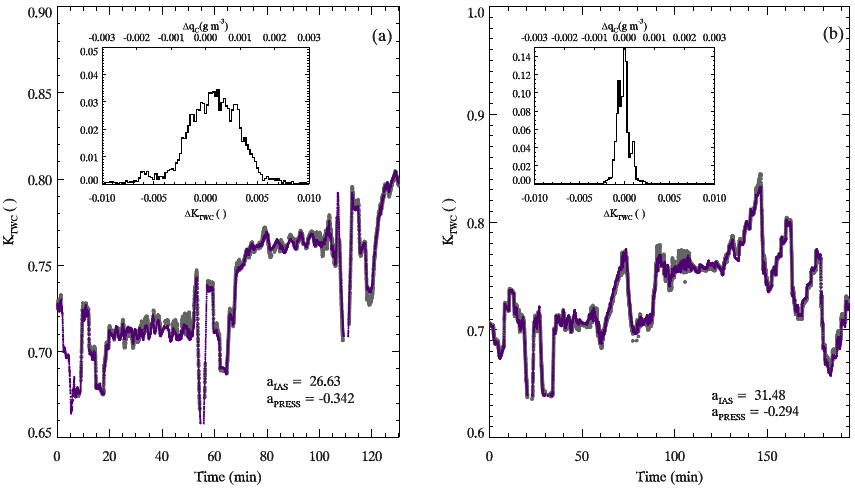
Figure A3. Data from cloud-free flights B666 (a) and B785 (b) . The grey line is the measured ratio of collector to reference power, and the purple line is the parametrised K . Inset are histograms of the difference between these variables. The effect of airspeed changes on K are clearly seen as steps in panel (b) between times 130 and 200min.